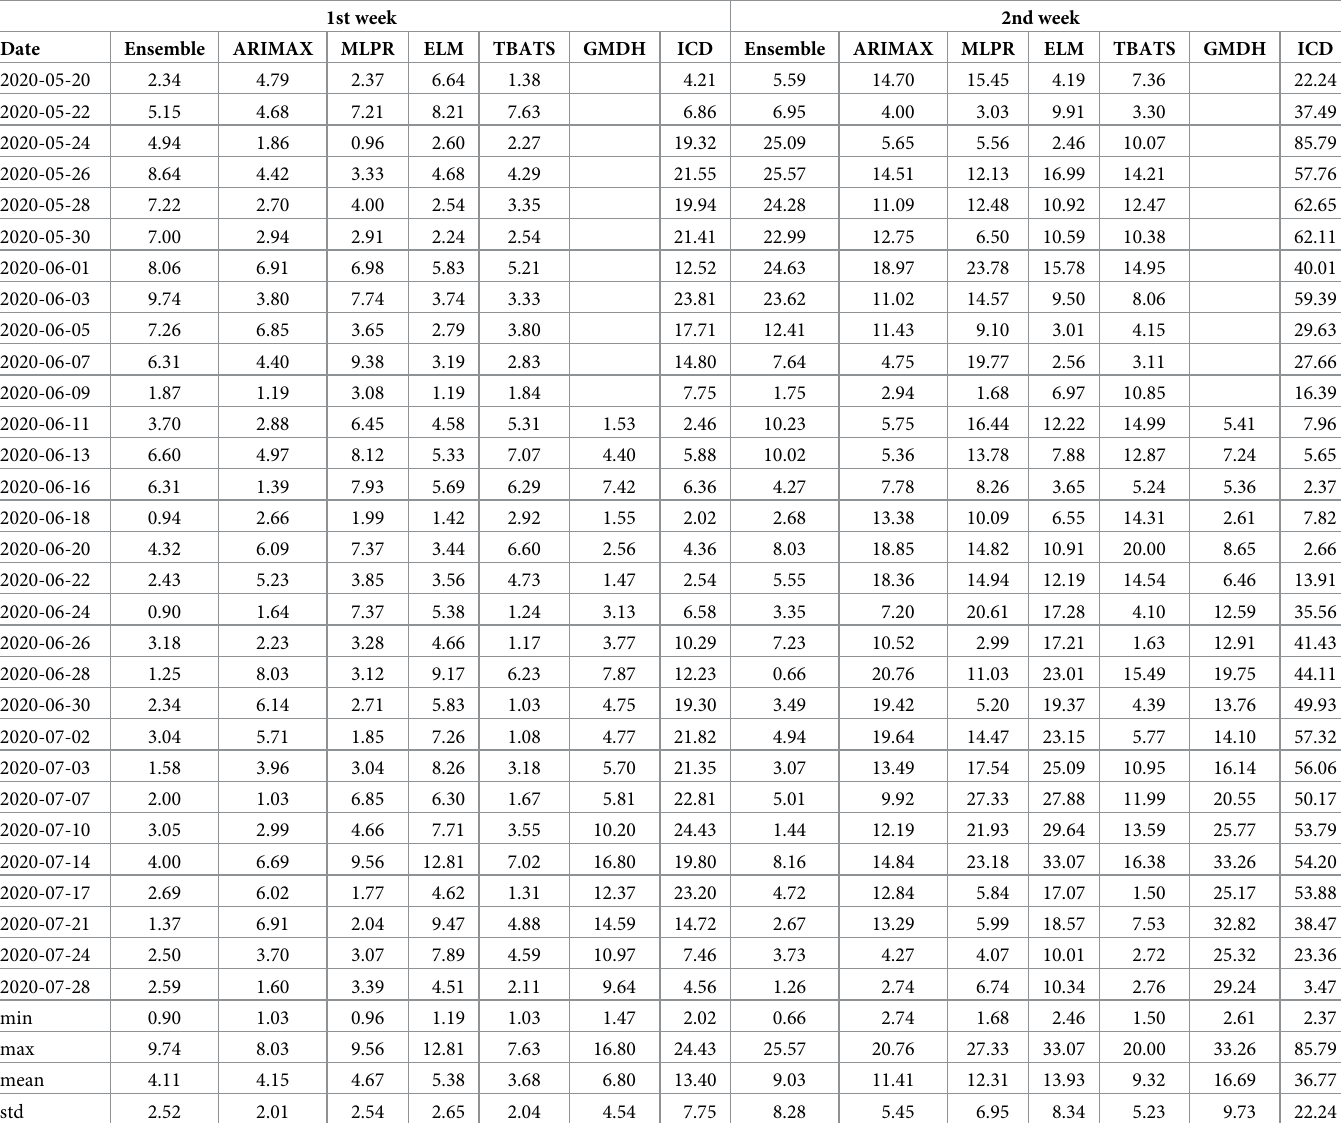
Table 2. Historical MAPE per model—Metropolitan